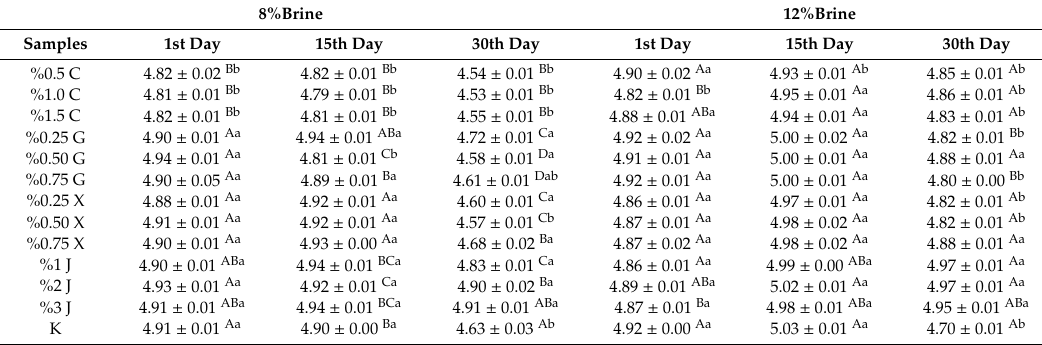
Table 2. pH properties of cheese samples during storage.